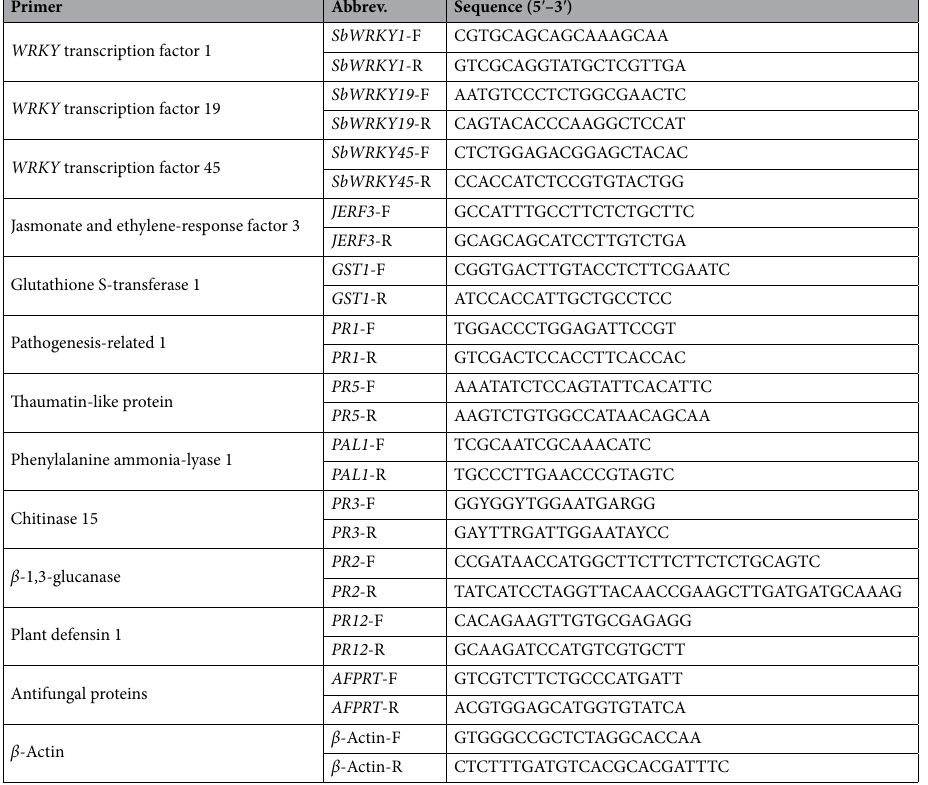
Table 7. Sequences of primer used in this